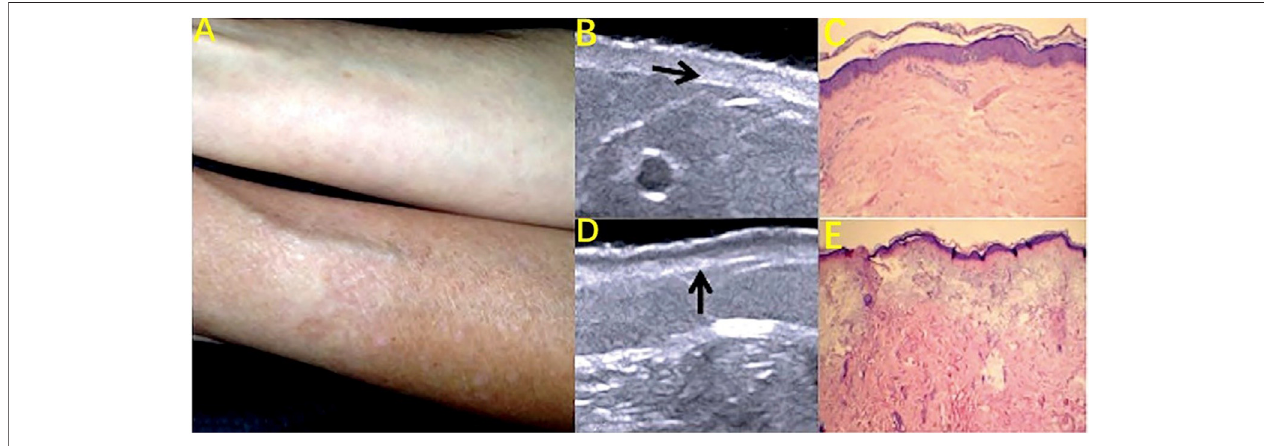
FIGURE 6 | Skin photoaging: subcutaneous low-echo band (SLEB) on HFUS images. (A) Photography of the ventral and dorsal areas of the forearm; (B) Decreaseddermisechogenicity(arrow)onHFUSimage. (C) Discretedegenerationofcollagen fi bers.Hematoxylinandeosin(HandE)staining(10X). (D) SLEB(arrow)on the HFUS image. (E) Solar elastosis. H and E staining